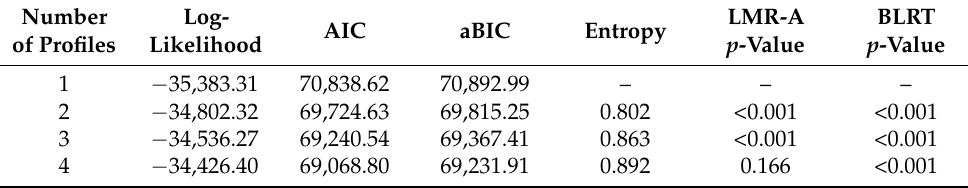
Table 3. Latent Profile Enumeration using 23 indicators of barriers to care.